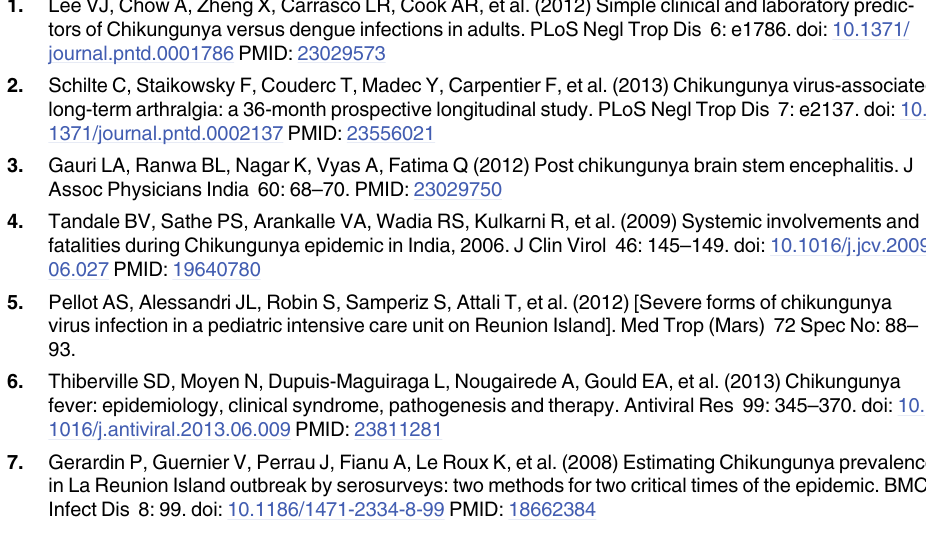
S2 Fig. Sequence alignment data. E2 glycoprotein sequences of different CHIKV stocks used in this study were shown. Ross strain (black color) and LR OPY1 strain (blue color).